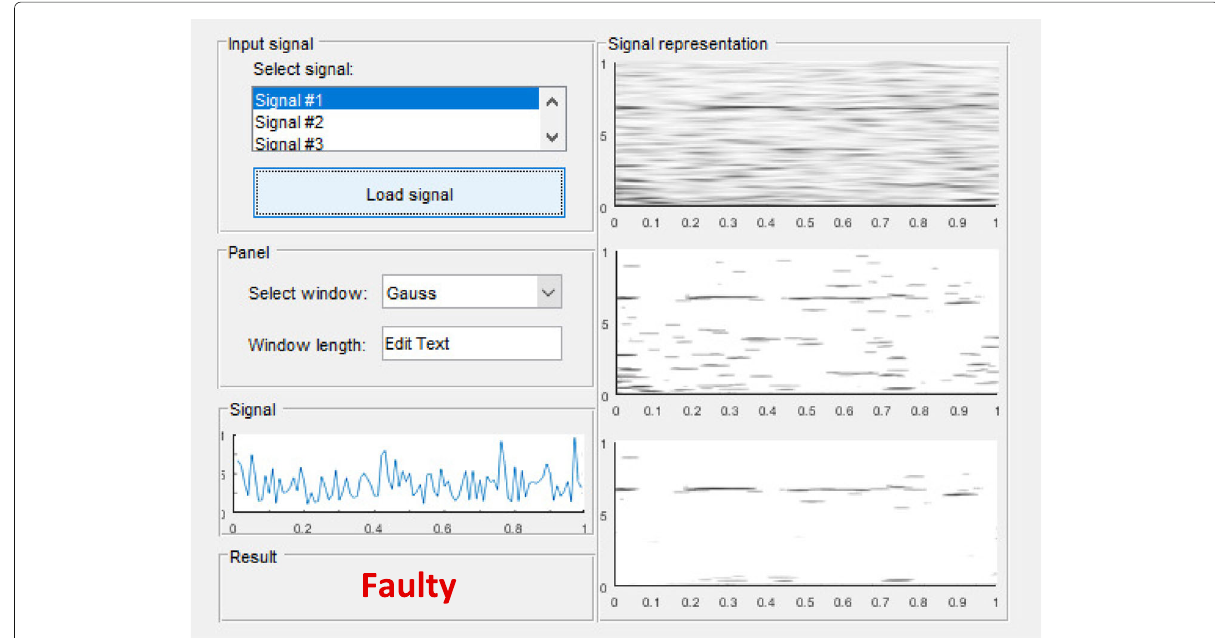
Fig. 13 GUI of software tool prototype of a computer-aided decision